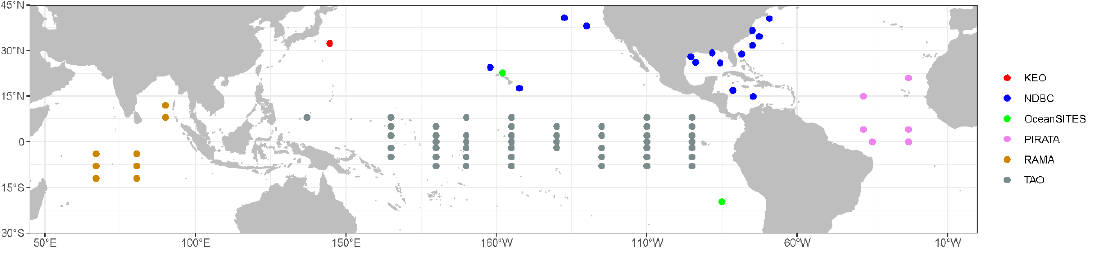
Figure 5. Location of buoys used for CYGNSS Flux Product validation.